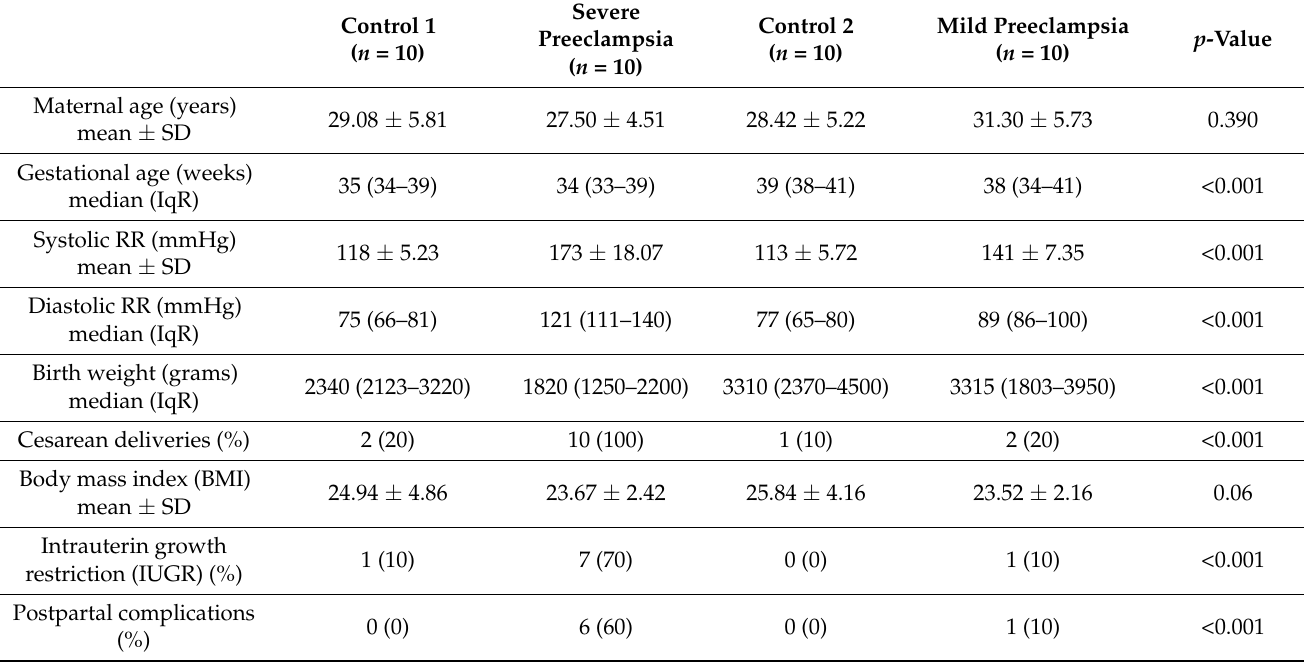
Table 1. Clinical features of the patients in the study